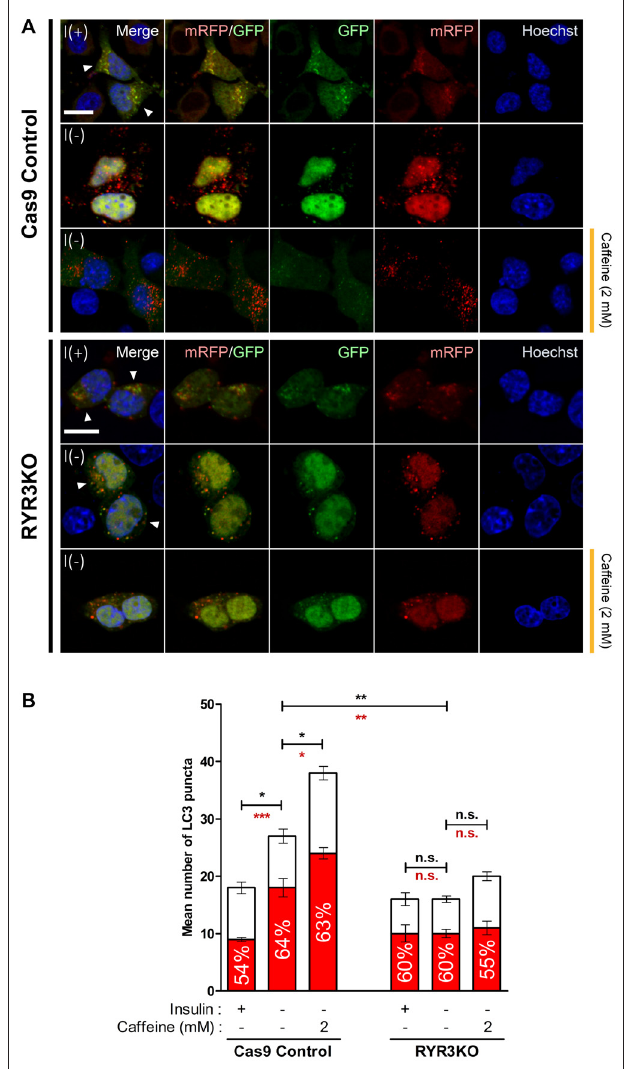
FIGURE 8 | Autophagic flux in RYR3KO HCN cells is unaltered upon insulin withdrawal or caffeine treatment. (A,B) Caffeine failed to induce autophagic flux of I( − ) HCN cells in the absence of RyR3. (A) Immunofluorescence analysis of HCN cells transfected with mRFP-GFP-LC3 tandem construct. Images were analyzed 24 h following insulin withdrawal with or without caffeine treatment. Cells subjected to analysis are indicated by arrowheads. Scale bar, 10 µ m. (B) Quantification of mRFP- and GFP-LC3 puncta in RYR3KO HCN cells treated with caffeine compared to controls ( n = 22 for Cas9 Control I(+), 30 for Cas9 Control I( − ), 27 for Cas9 Control I( − )/Caffeine, 29 for RYR3KO I(+), 34 for RYR3KO I( − ), 25 for RYR3KO/Caffeine). The bars represent the mean ± SEM; ∗ p < 0.05, ∗∗ p < 0.01, ∗∗∗ p < 0.001; n.s., non-significant. The black and red asterisks indicate the statistical significance in the comparison of total and mRFP puncta numbers,